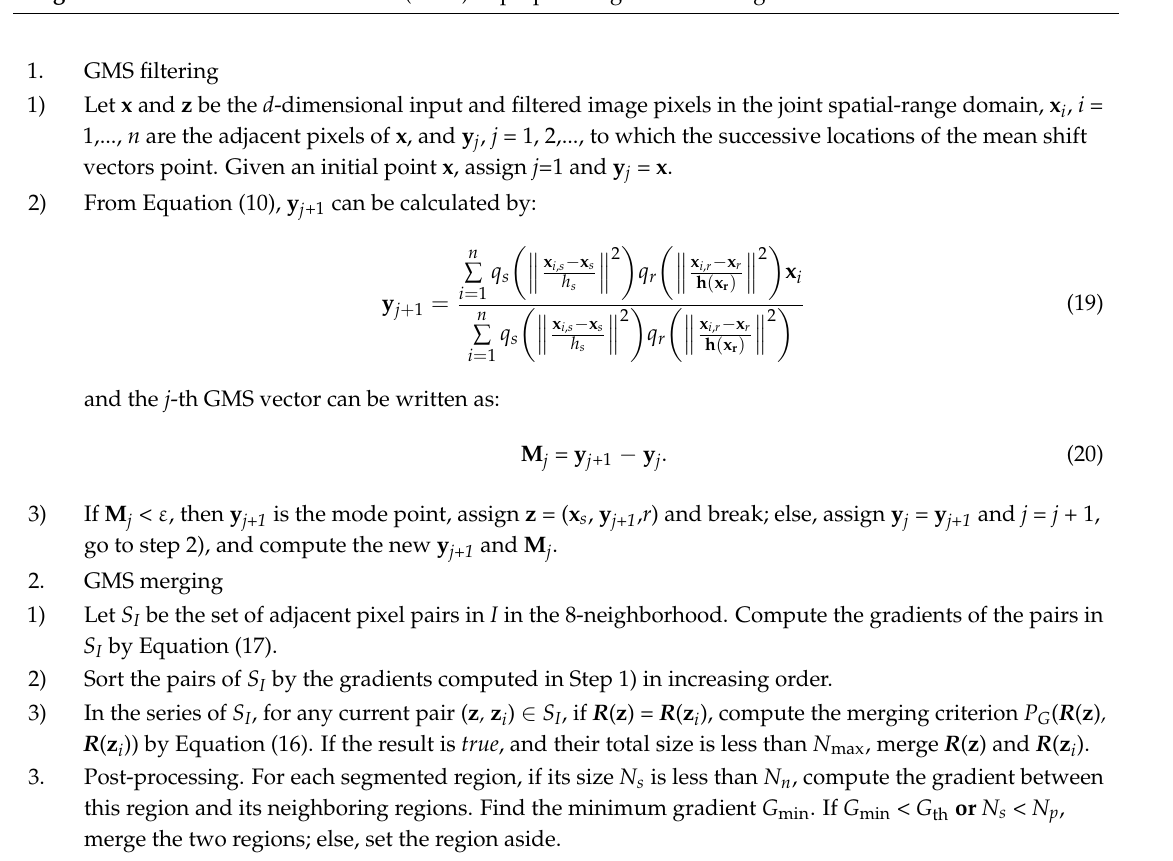
Algorithm 2. Generalized Mean Shift (GMS) Superpixel Segmentation